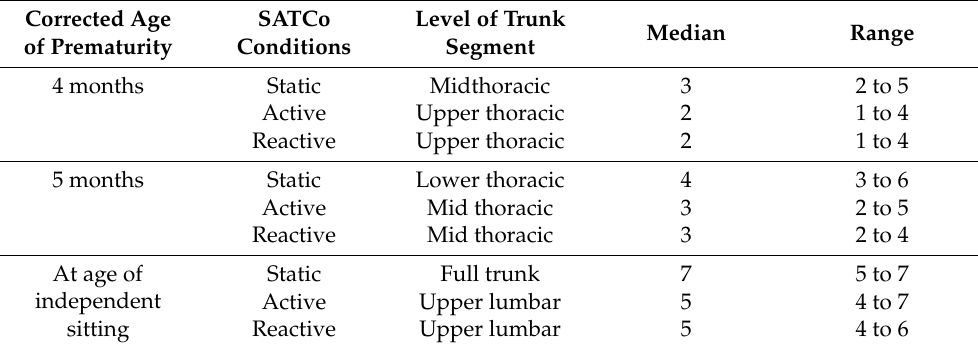
Table 2. SATCo scores of each condition at 4- and 5-month corrected ages, and at the corrected age of independent sitting ( n =